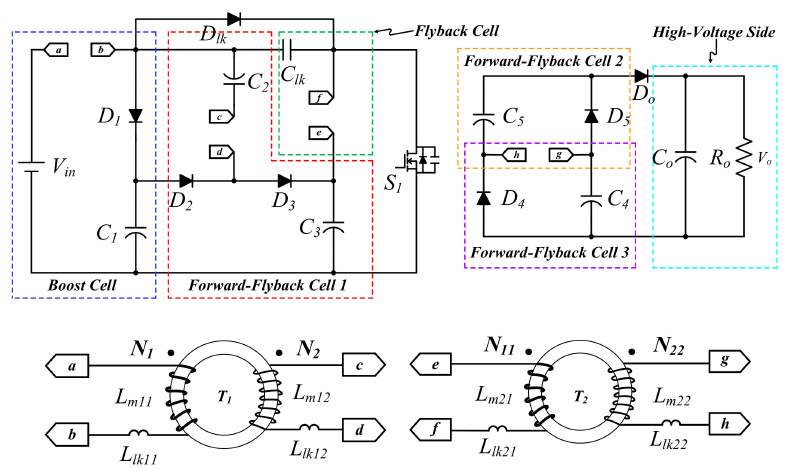
Figure 1. The main power stage of the proposed single-switch isolated ultra-high step-up converter